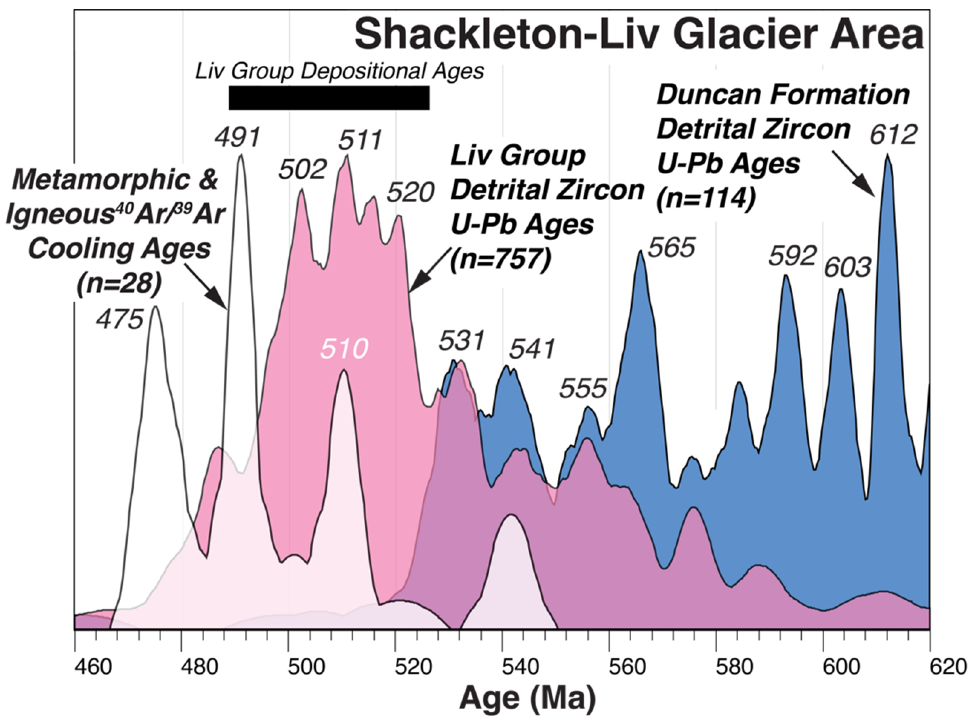
Figure 10. Stacked kernel-density-estimation diagrams [73] showing in situ igneous and metamorphic 40 Ar/ 39 Ar cooling ages, Liv Group detrital zircon U-Pb ages, and Duncan Formation detrital zircon U-Pb ages falling within the 620–460 Ma time period from the Shackleton Glacier area (Ramsey to Liv Glaciers) of the Ross orogen. In situ igneous and metamorphic 40 Ar/ 39 Ar cooling ages are compiled from data presented in this paper, as well as [45,46,48,51,54]. Detrital zircon ages are compiled for the Liv Group and Duncan Formation from [26,27,54].